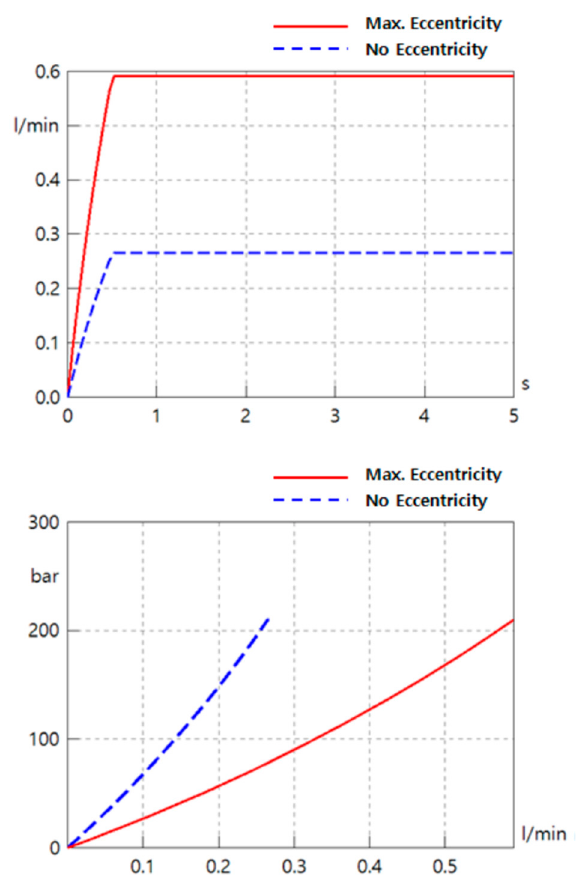
Figure 9. Result of labyrinth seal simulation.